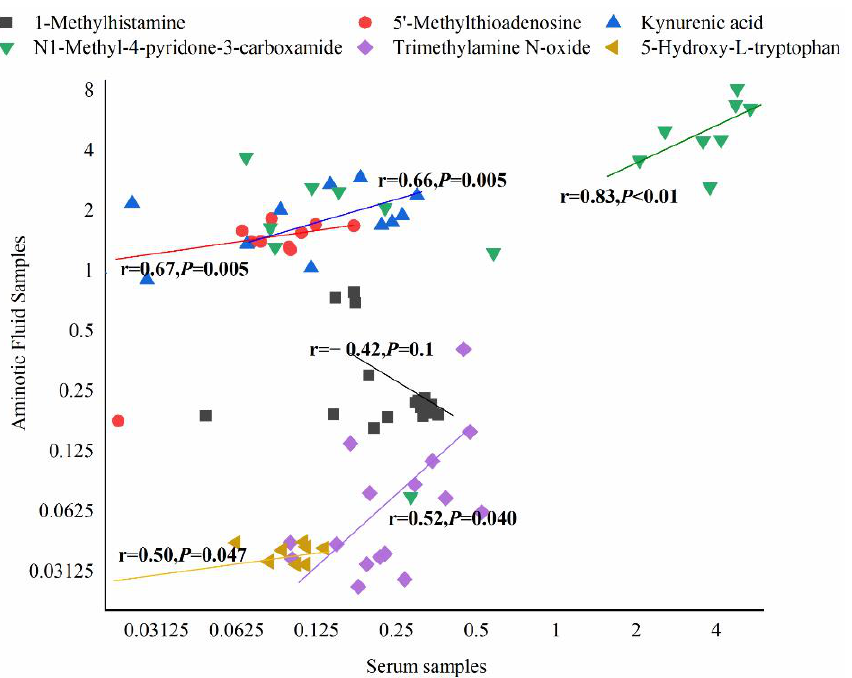
Figure 7. The scatter plots of common metabolites related to maternal or fetal health indicators in serum and AF samples. The horizontal axis: log2 transformation of the concentration of metabolites in serum. The vertical axis: log2 transformation of the concentration of metabolites in AF